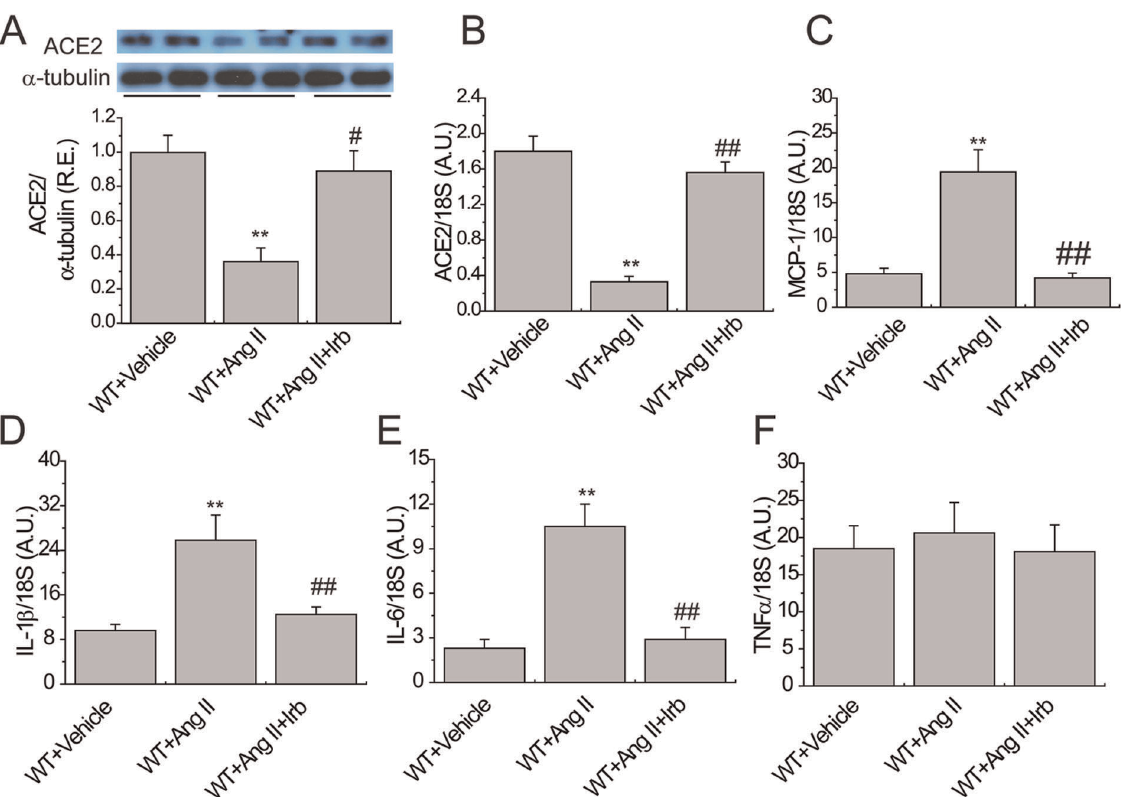
Figure 4. Aortic ACE2 expression and inflammation in Ang II-infused mice following irbesartan treatment. Representative Western blot analysis exhibited aortic protein levels of ACE2 (A) in WT mice (n=5). a -tubulin (55 kD) was used as an endogenous control. TaqMan real-time PCR analysis showed the mRNA expression of ACE2 (B) and inflammatory cytokines MCP-1 (C), IL1 b (D), IL6 (E), and TNF- a (F) in the aortas of WT mice (n=6 2 8). A.U., arbitrary units; Irb, irbesartan; See Figure 1 for other abbreviations. ** P , 0.01 compared with WT + vehicle group; # , P , 0.05 ## , P , 0.01 compared with WT + Ang II group.